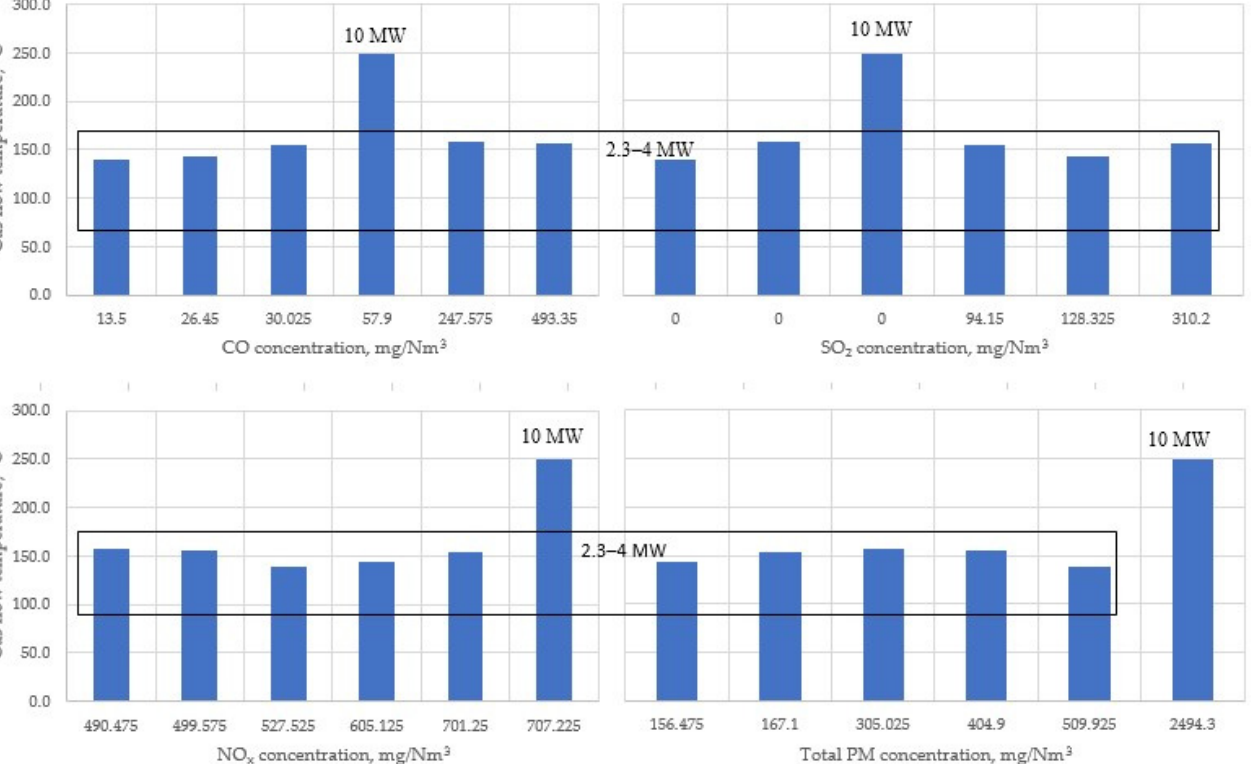
Figure 4. The concentrations of pollutants emitted at different shares of lignin in the burnt fuel under varying power of the boiler in combustion mode.